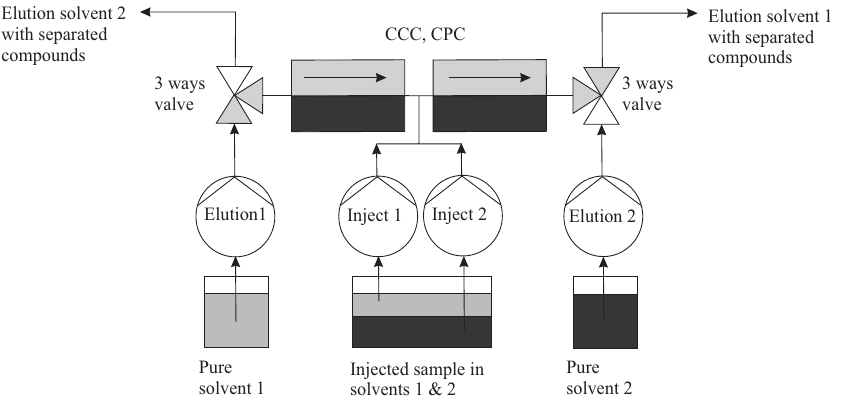
Figure 13. The topology which corresponds to the TMB mode is close to that of MDM. Injections in between two columns are performed by dedicated pumps. Elution pump 1 works synchronously with injection pump 1 in the forward direction (and vice versa pump